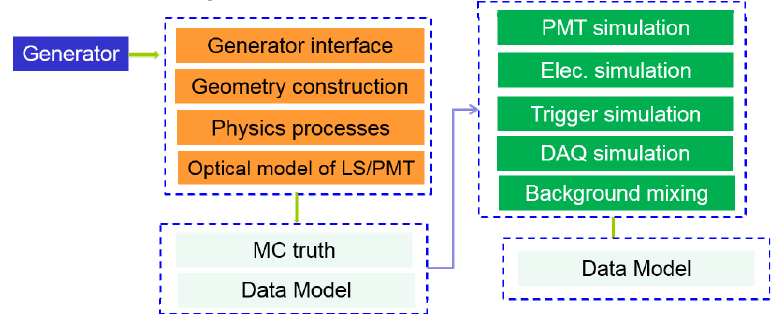
Fig.4. Components in simulation software.